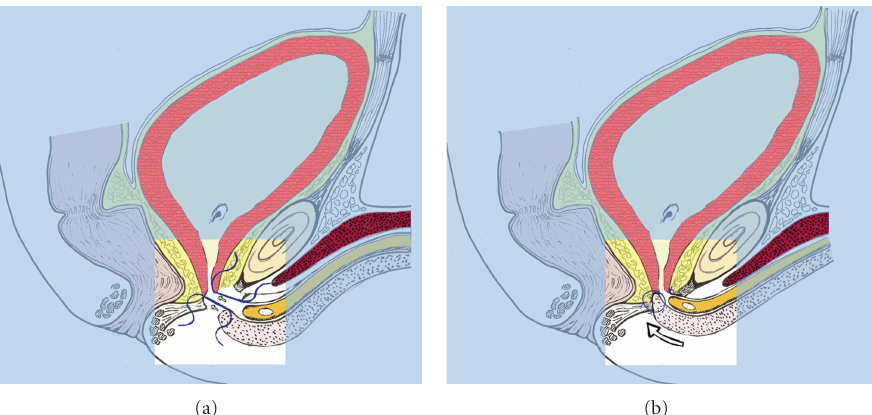
Figure 1: (a) Two 3–0 polygalactinin sutures are passed through the proximal edge of the urethra and the bladder neck. (b) The sutures are